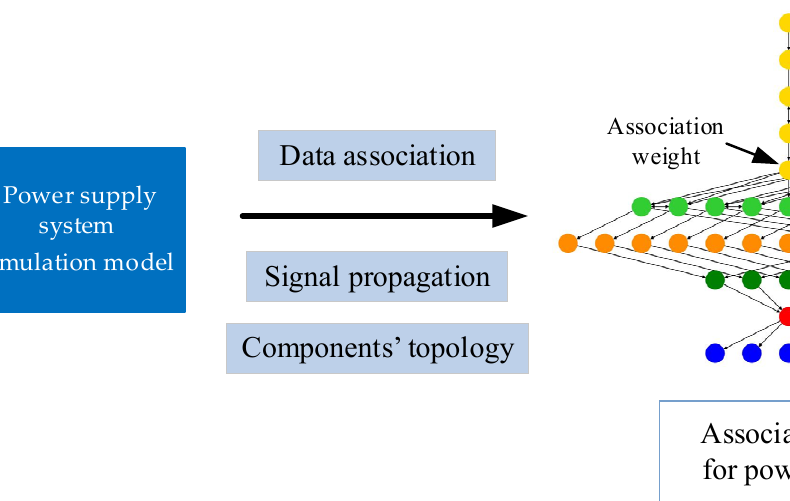
Figure 4. Reconstruction and reduction of the power supply system association graph